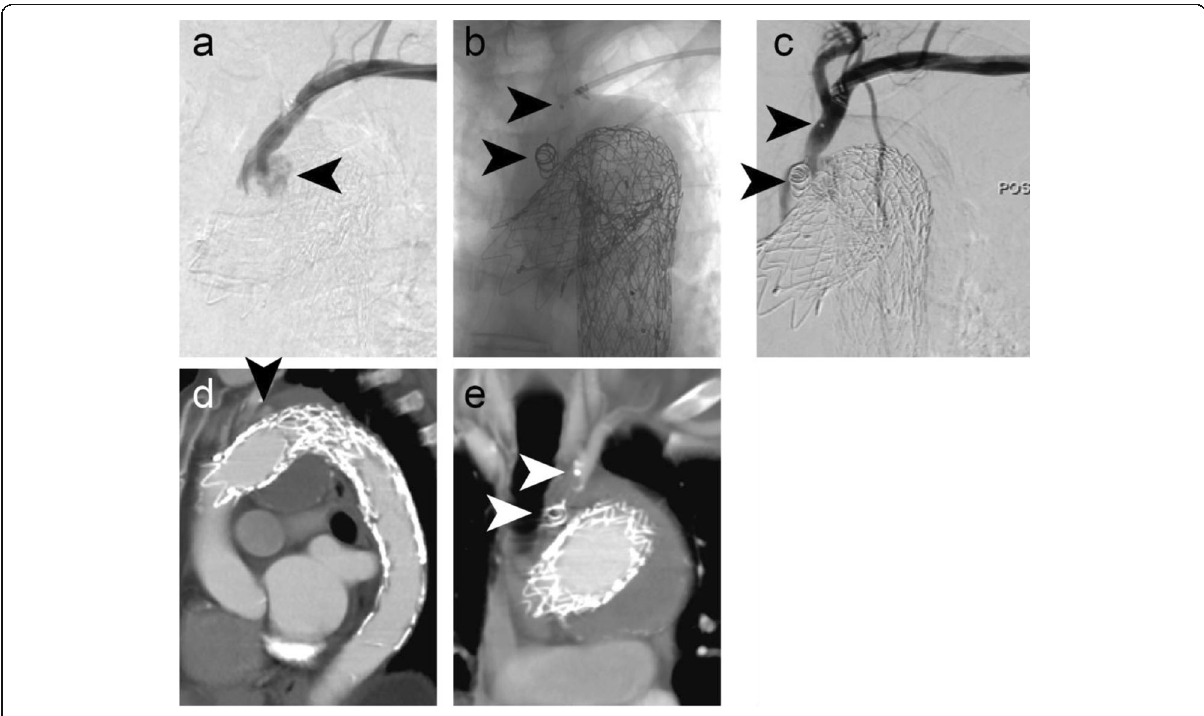
Fig. 4 Case 4. a Pre-embolisation DSA imaging of a type II endoleak into the thoracic aorta following TEVAR. b Intraprocedural DSA imaging following delivery of a 12 mm diameter shape memory polymer plug into the 10 mm diameter left subclavian artery. Arrows indicate the anchor coil and proximal marker. Shape memory polymer is radiolucent but is between the anchor coil and proximal marker. c Contrast injection following deployment of the plug. A small endoleak is still present. It should be noted that although complete occlusion ultimately occurs, it may take 10 – 20 min to occur. d Preprocedural CTA shows the type II endoleak. e Six-week follow-up CTA confirmed no recurrence of the type II endoleak. Arrows indicate the device anchor coil and proximal